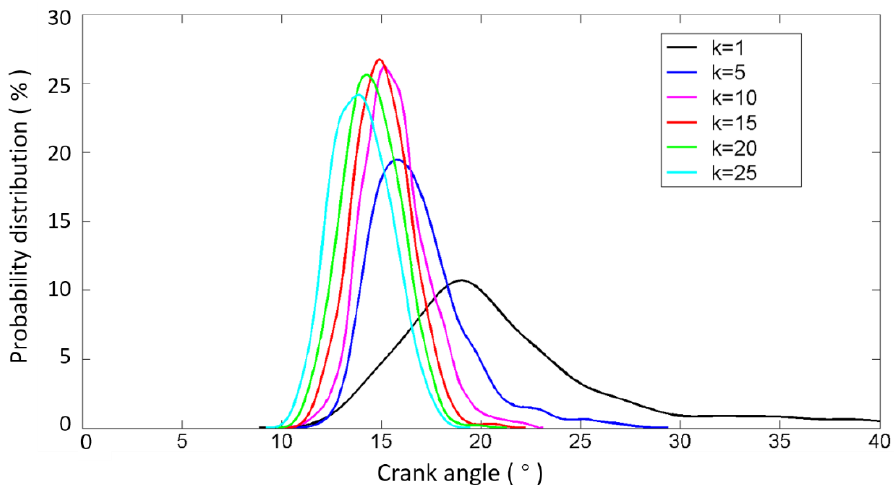
Figure 15. Probability distribution calculated by the further enhanced method to identify the commencement of B1-cylinder exhaust valve closing impact in 480 combustion cycles with different values of k. Table 5. Statistics of the commencement of B1-cylinder exhaust valve closing impact in 480 combustion cycles calculated by the further enhanced method with different values of k. k Mean